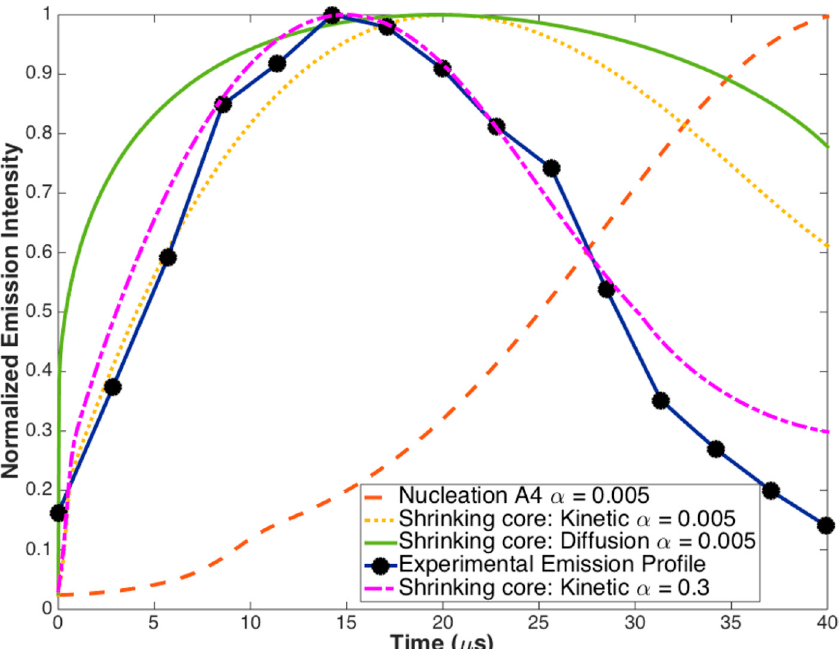
Figure 11. Model simulations for 40 nm Ti particle with α = 0.005 and α = 0.3. Reprinted from [30] with permission from J. Phys. Chem. A. Copyright 2015 American Chemical Society.